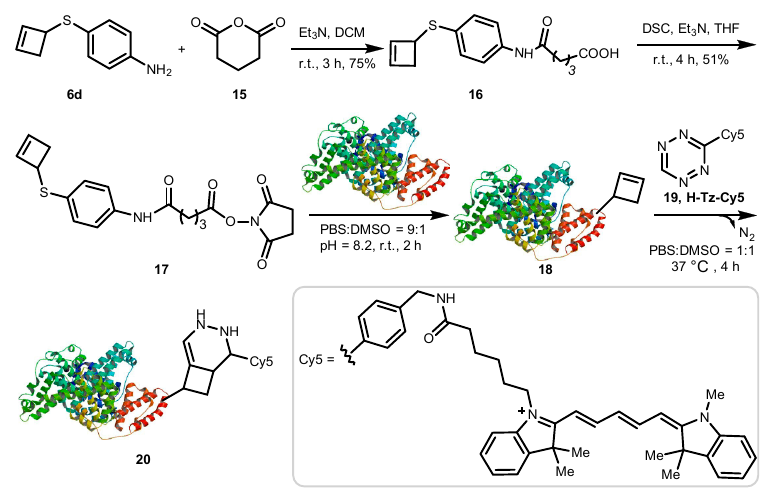
Scheme 2. In vitro cyclobutene modification and bioorthogonal labeling of protein bovine serum albumin (BSA).